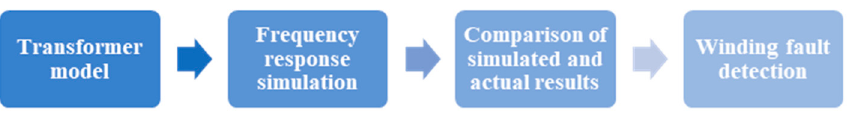
Figure 1. Diagram of fault detection in the active part of the transformer based on modelling [15].